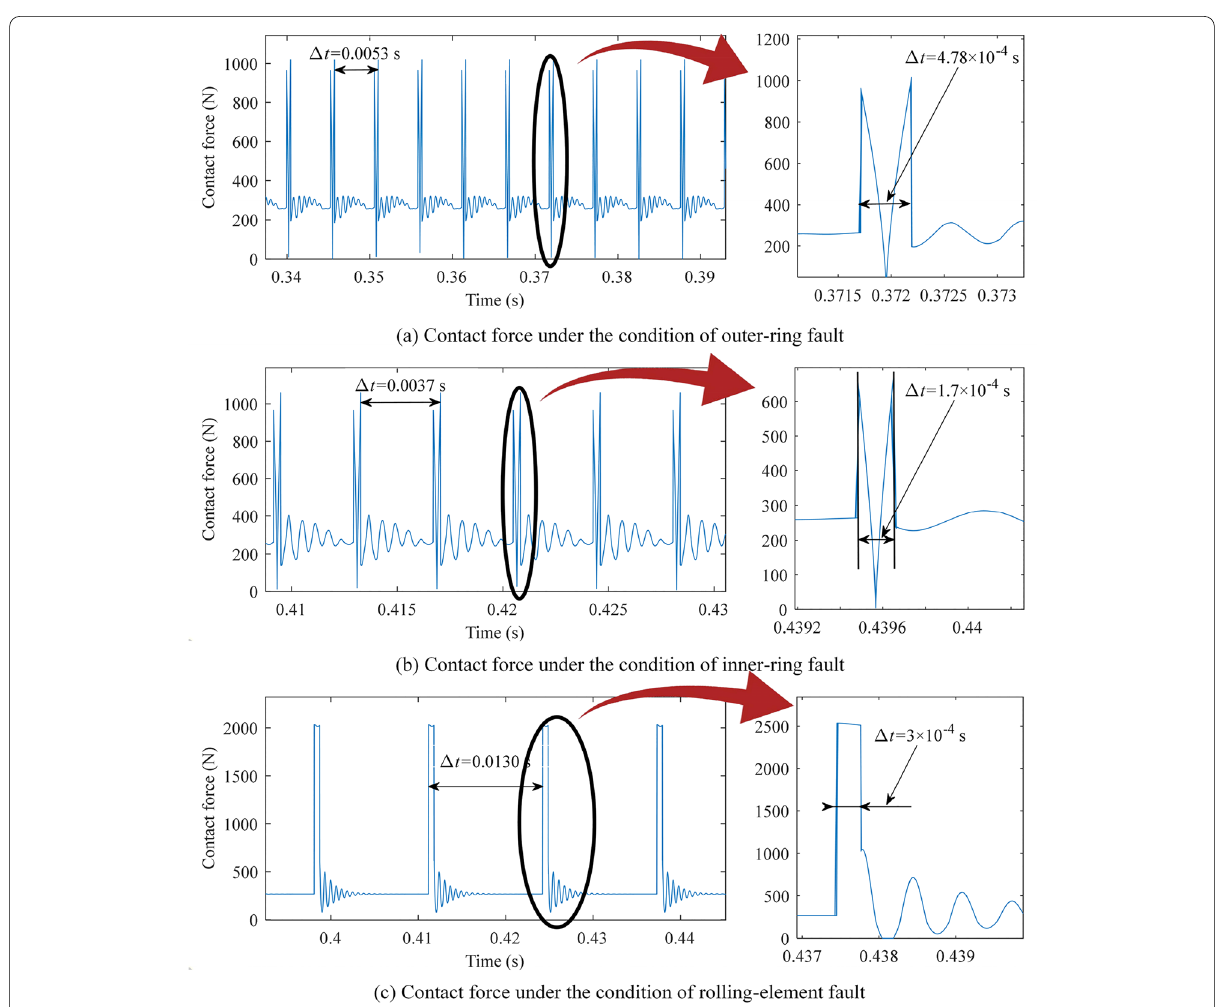
Figure 4 Resultant force of contact force between rolling-elements and